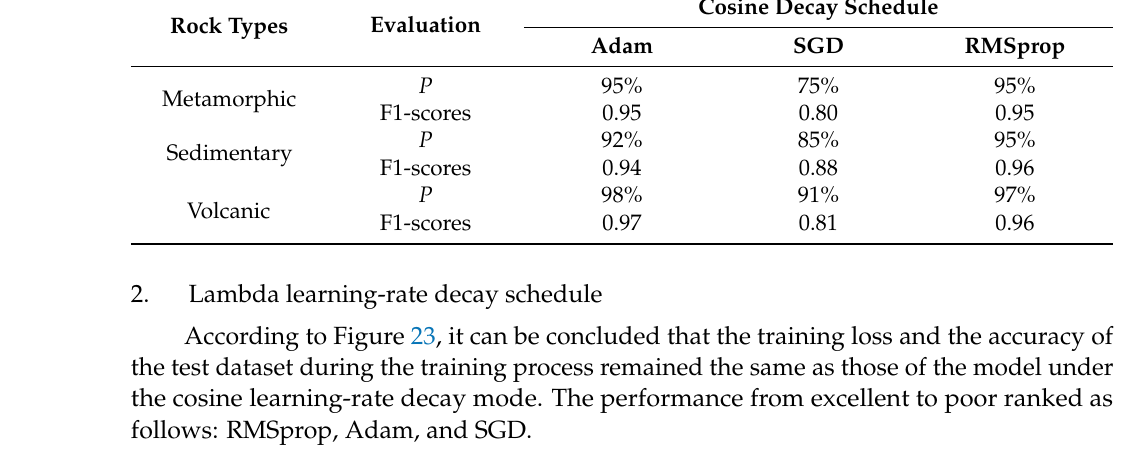
Figure 24. Confusion matrixes: ( a ) RMSprop optimizer; ( b ) SGD optimizer; ( c ) Adam optimizer. Table 9. Detailed classification results for all rock types. Rock Types